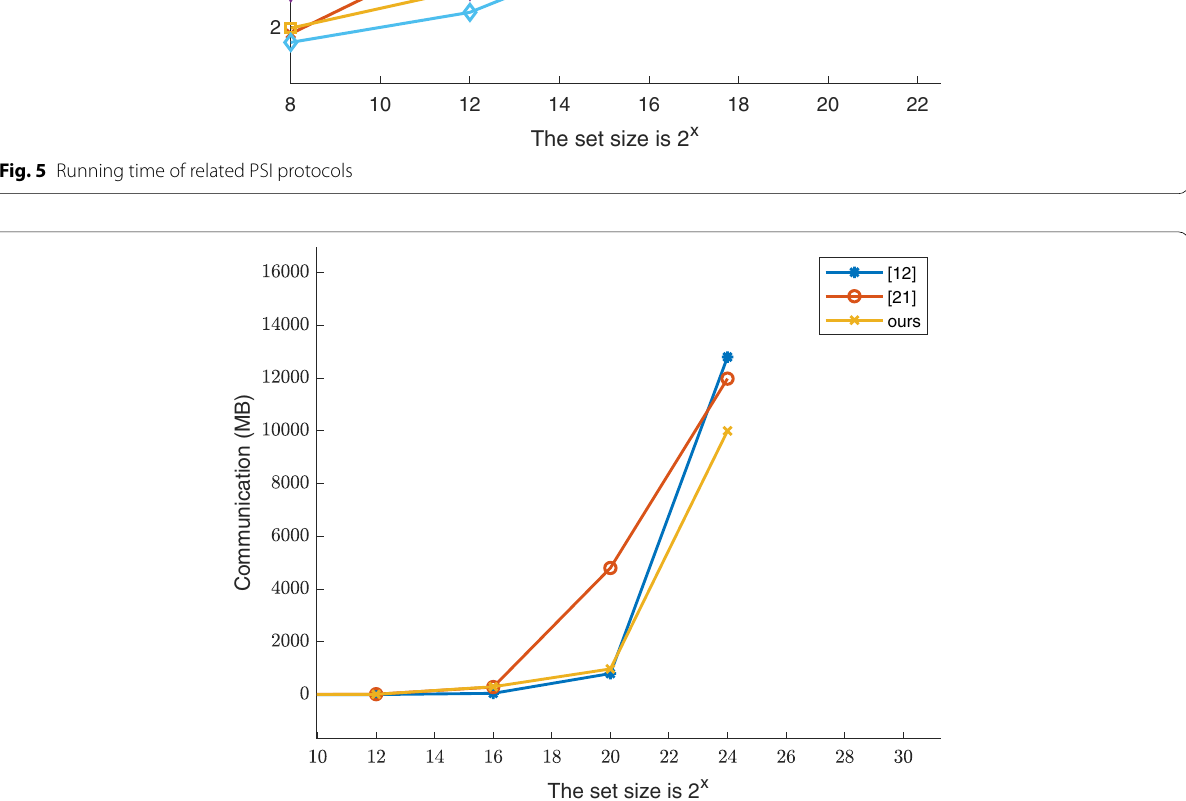
Fig. 6 Communication overhead of related PSI